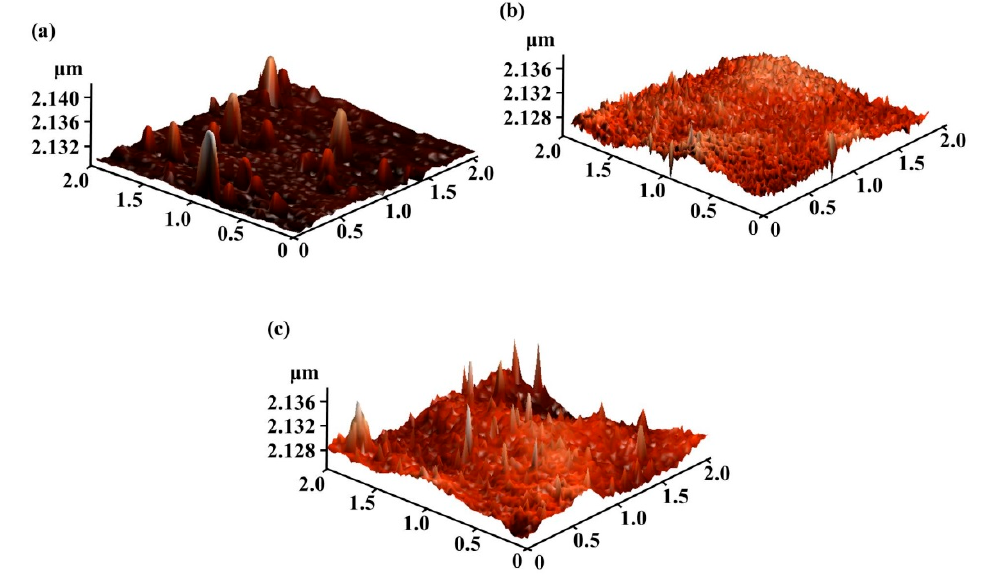
Figure 4. AFM image with RF deposition power of ( a ) sample A: 50W ( b ) sample B: 60W ( c ) sample C: 70W. The Rq values reached 1.207, 1.249, and 1.54, respectively.